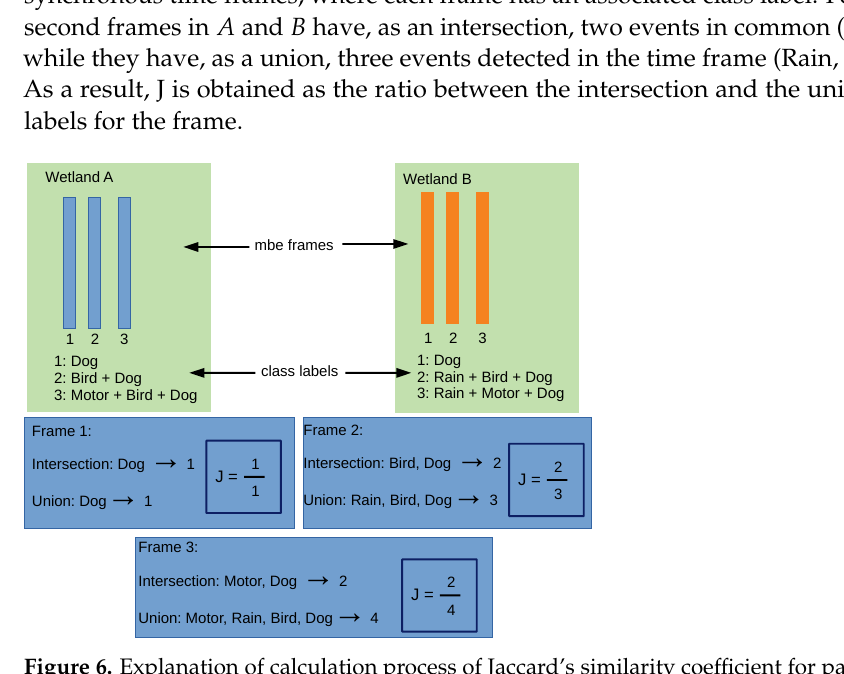
Figure 6. Explanation of calculation process of Jaccard’s similarity coefficient for particular